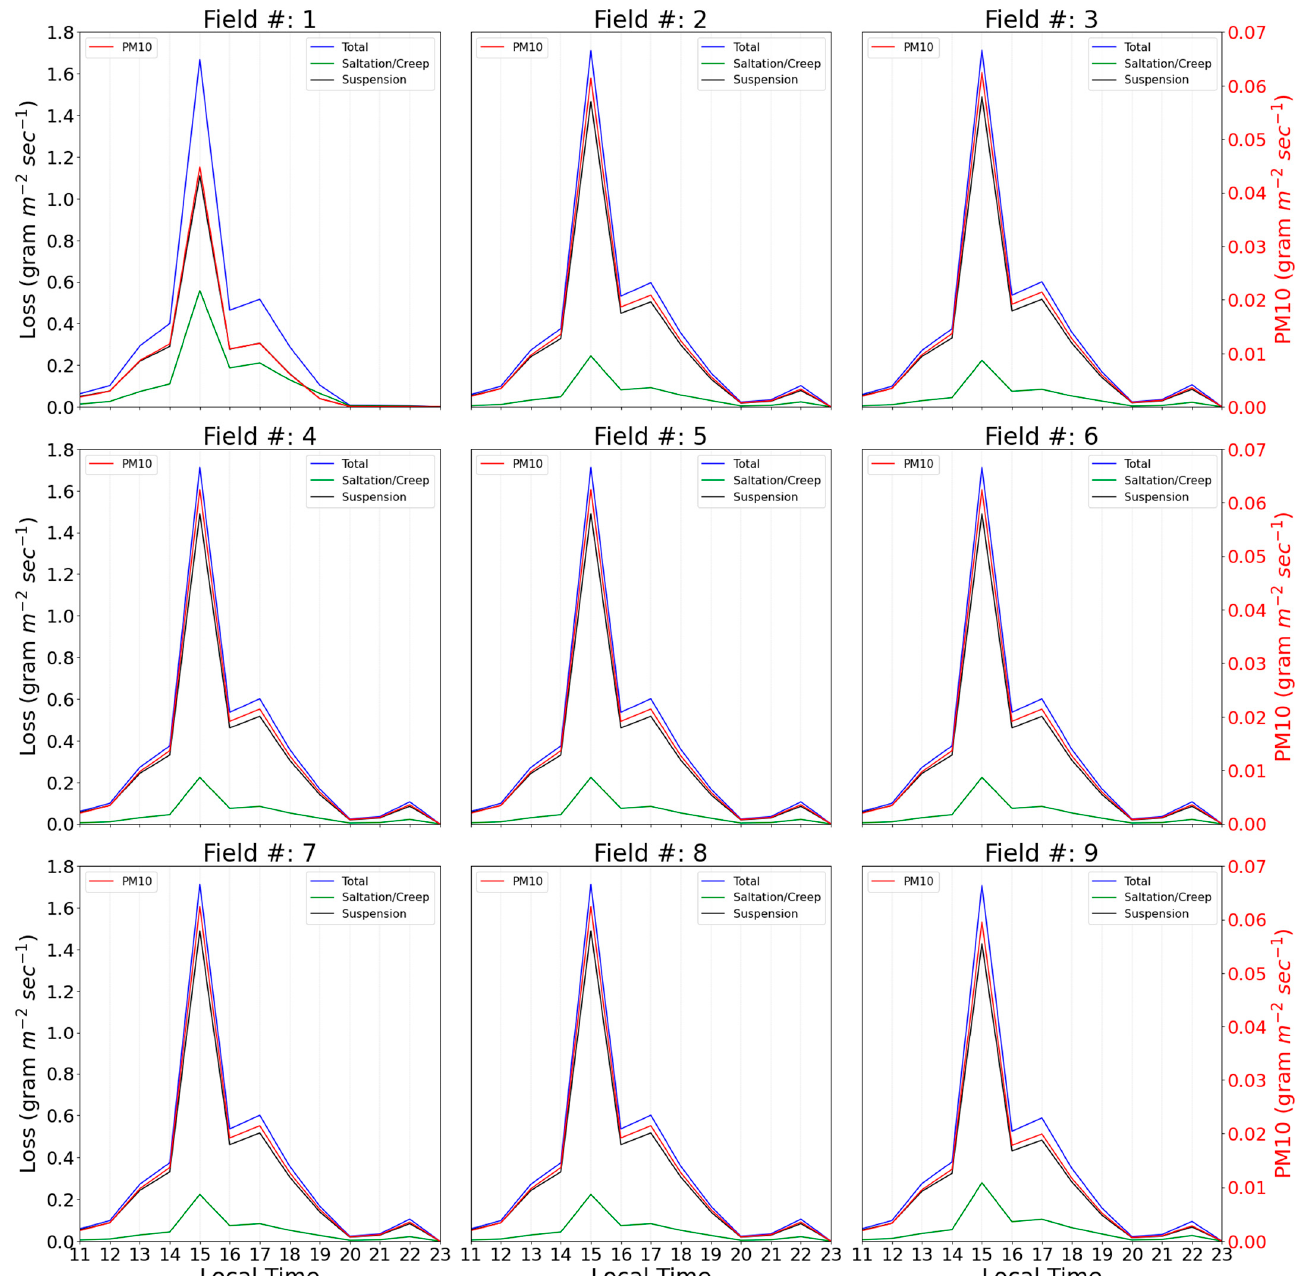
Figure 9. SWEEP simulated soil loss, in terms of the total, saltation/creep, suspension, and PM 10 from the North Playa field during the dust event of 5 June 2020. The left y-axis represents the total, saltation/creep, and suspension loss, and the right y-axis (twin y-axis) represents PM 10 .